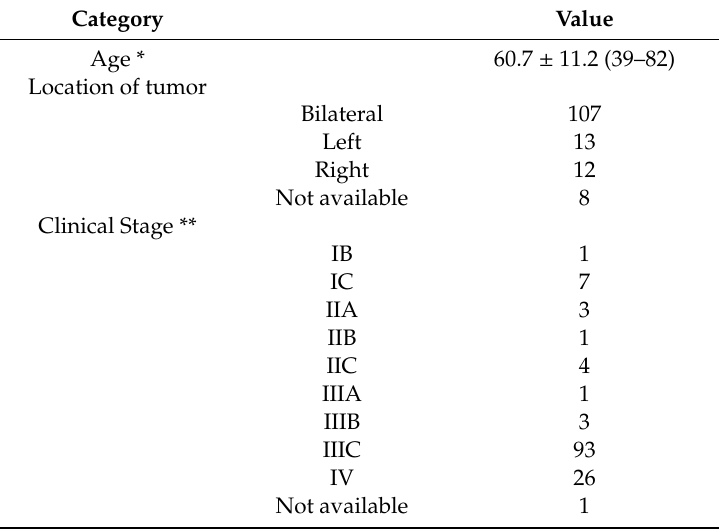
Table 4. Patient demographics of